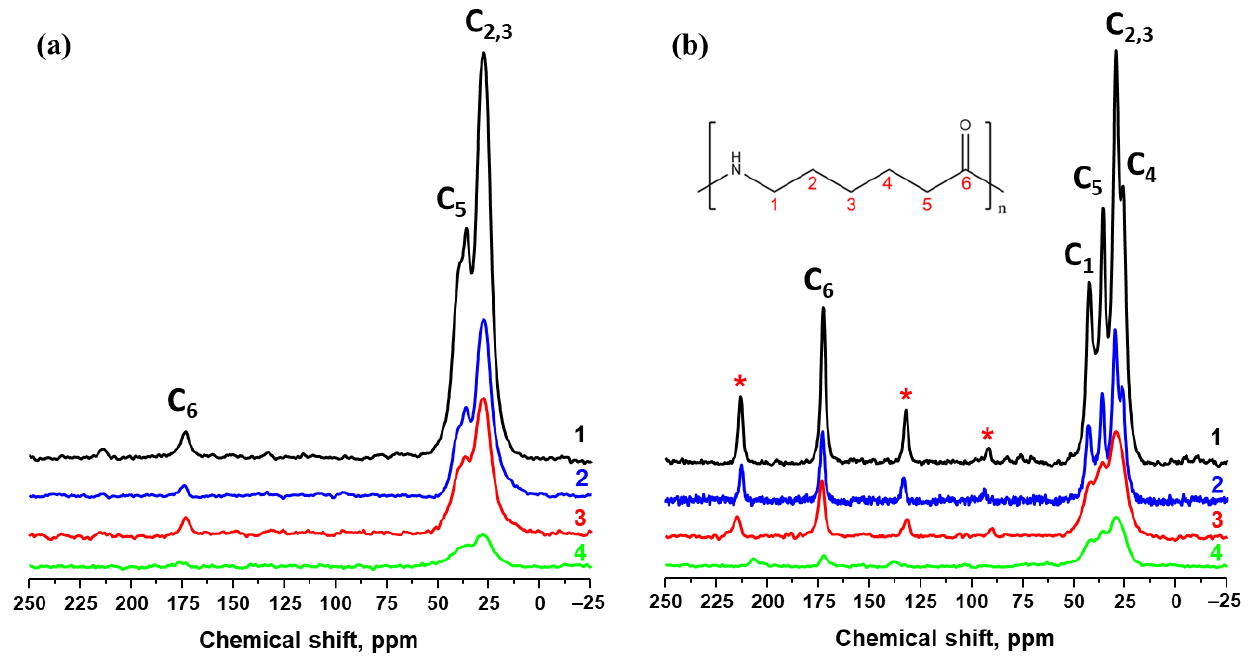
Figure 2. Full ssNMR spectra comparison of Me-MP samples at room temperature: ( a ) 13 C MAS and ( b ) 13 C CP/MAS. 1—PA6, 2—Cu10, 3—Al10, 4—Mg10. Asterisks denote spinning sidebands.